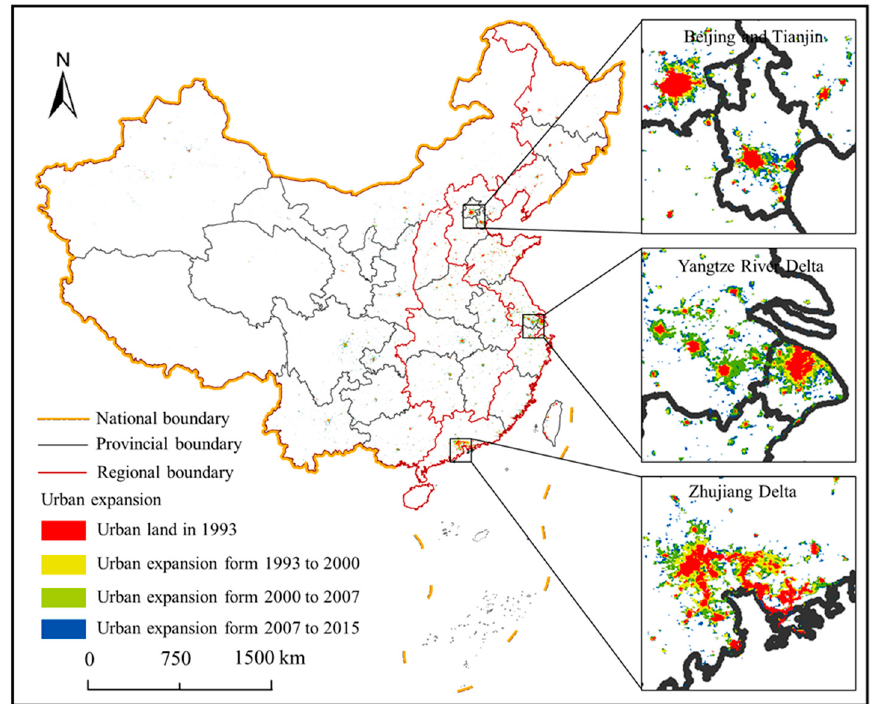
Figure 3. Spatial distribution of urban land in China.